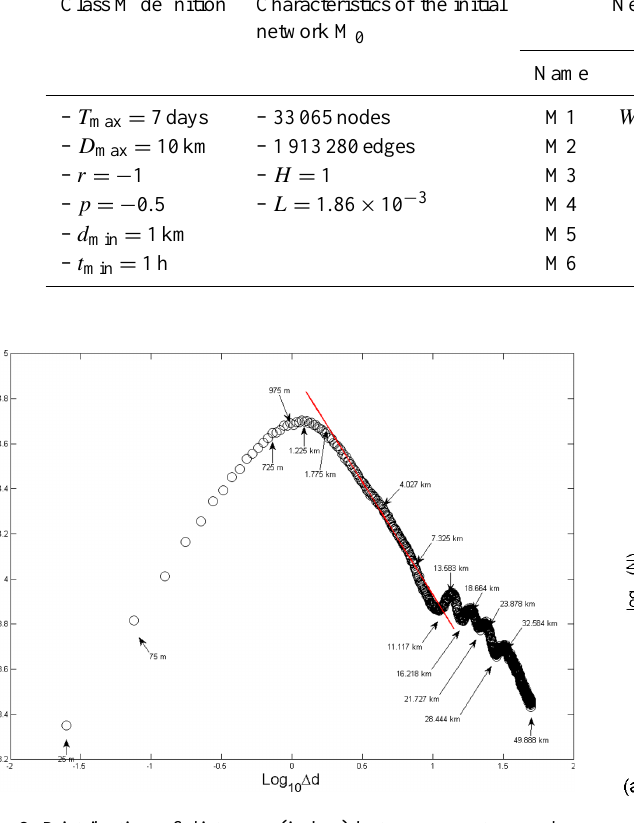
Fig. 6. Distribution of distances (in km) between any two nodes in the initial network E 0 . N is the number of distances of 1d km between any two earthquakes in a space–time window of 50km and 40days. The red line represents a reference line with the slope of − 1.